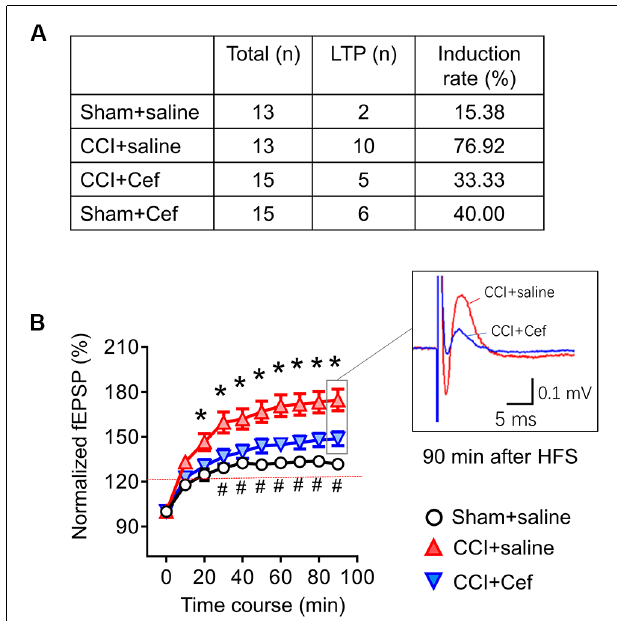
FIGURE 6 | Reversal effects of repeated systemic administration of ceftriaxone (Cef) on CCI-ION-induced enhancement of long-term potentiation (LTP) induction and maintenance. Panel (A) shows induction rate of LTP induced by high frequency burst stimulation (10 bursts/s, 4 × 0.2 ms pulses at 100 Hz, 60 µ A for each burst) in rats of Sham + saline ( n = 13), CCI + saline ( n = 13), CCI-Cef ( n = 15) and Sham + Cef ( n = 15) groups. (B) Time courses of LTP in rats of Sham + saline (15 electrode points from two rats), CCI-saline (49 electrode points from seven slices), and CCI + Cef (24 electrode points from five slices) groups. Data are presented as mean ± SEM. * p < 0.05, CCI + saline vs. Sham + saline; # p < 0.05, CCI + Cef vs.